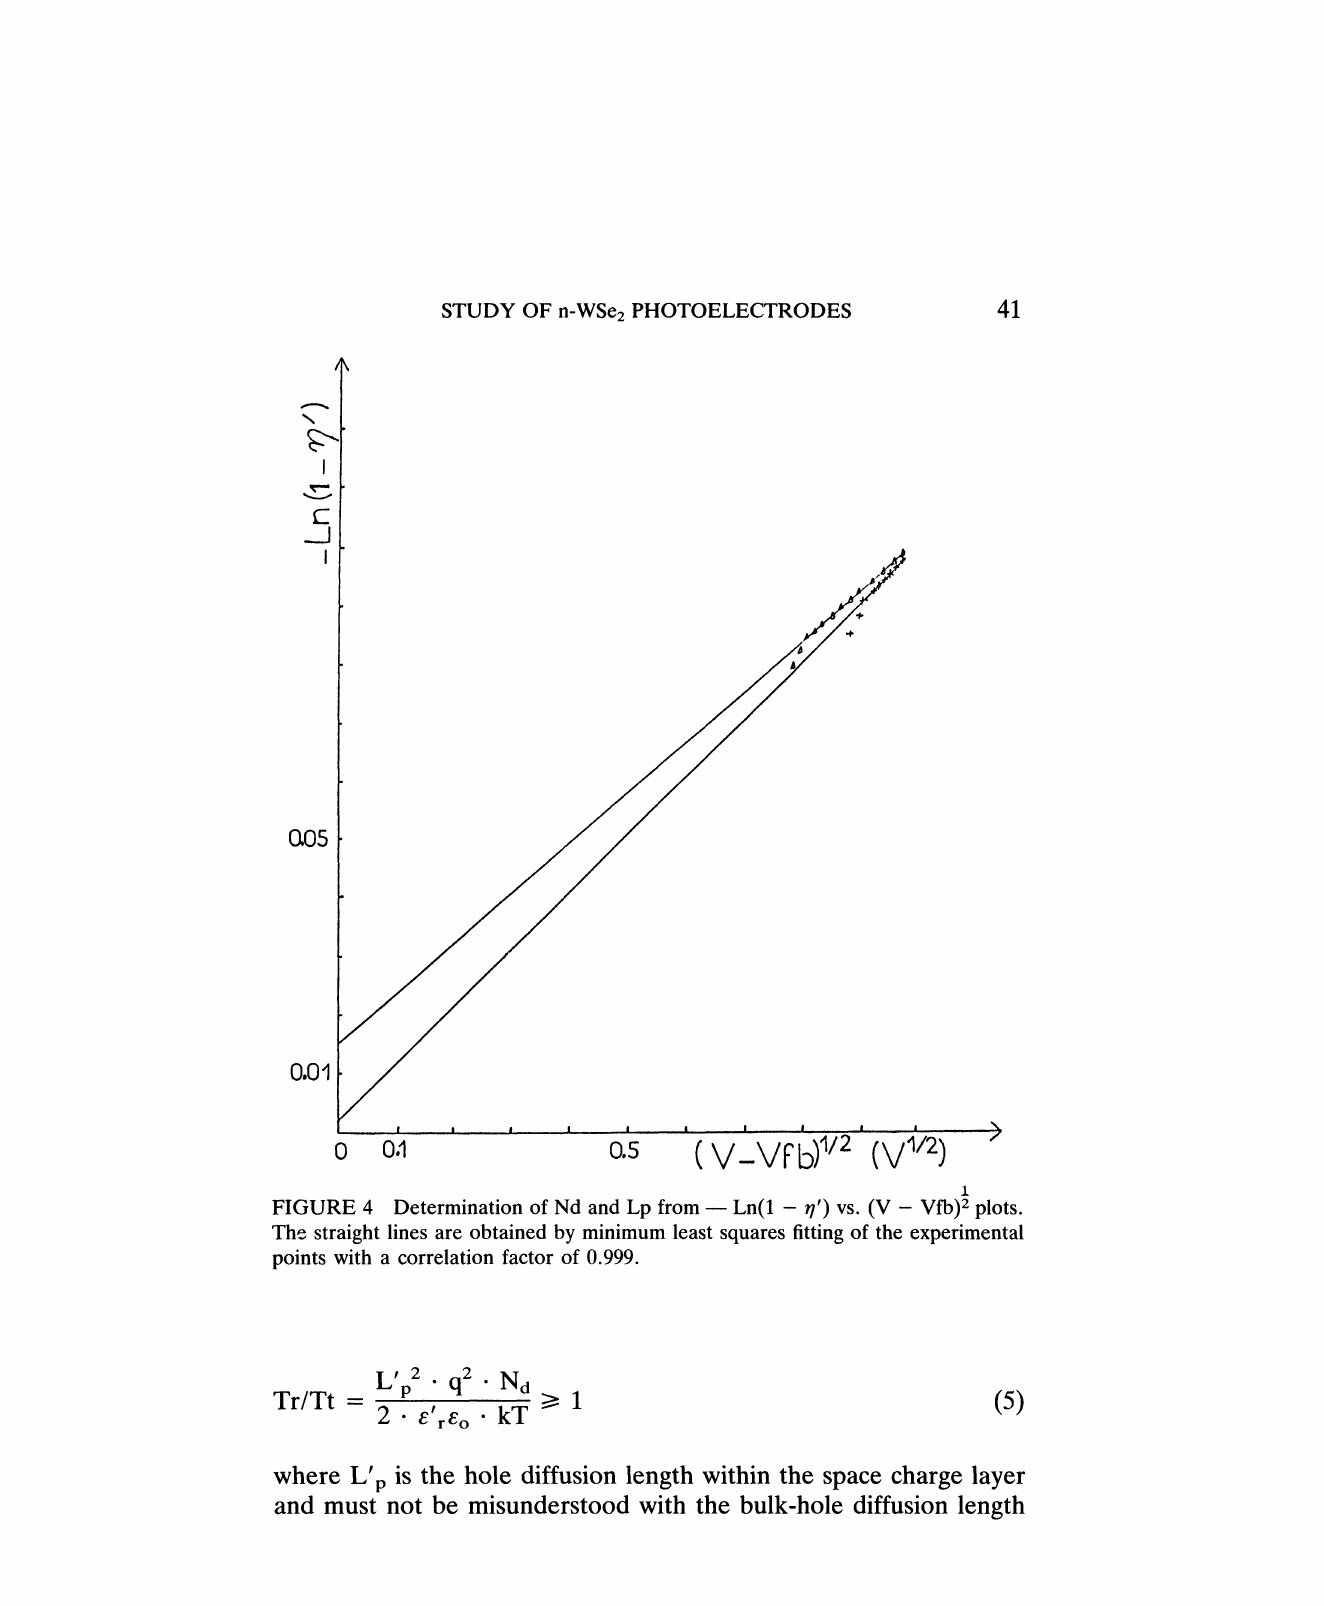
Th straight lines are obtained by minimum least squares fitting of the experimental points with a correlation factor of